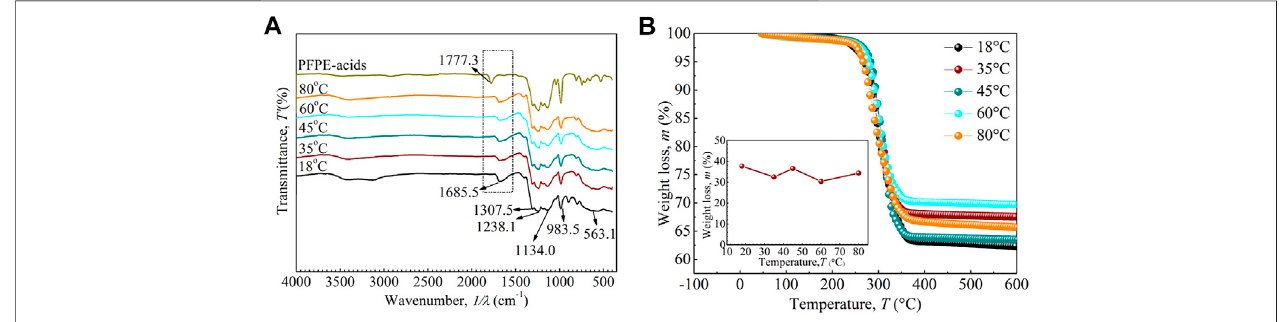
FIGURE5 |(A) FTIR curvesofPFPE-acids and coated Fe 3 O 4 nanoparticles with different particle sizes, (B) TGA curves ofFe 3 O 4 nanoparticles coated with PFPE- acids.